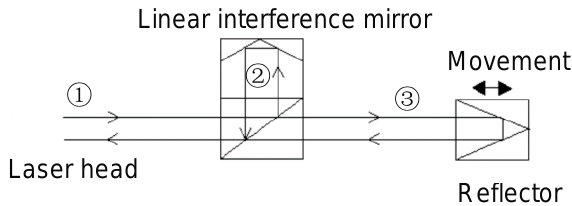
Figure 4. Measurement principle of the laser interferometer.